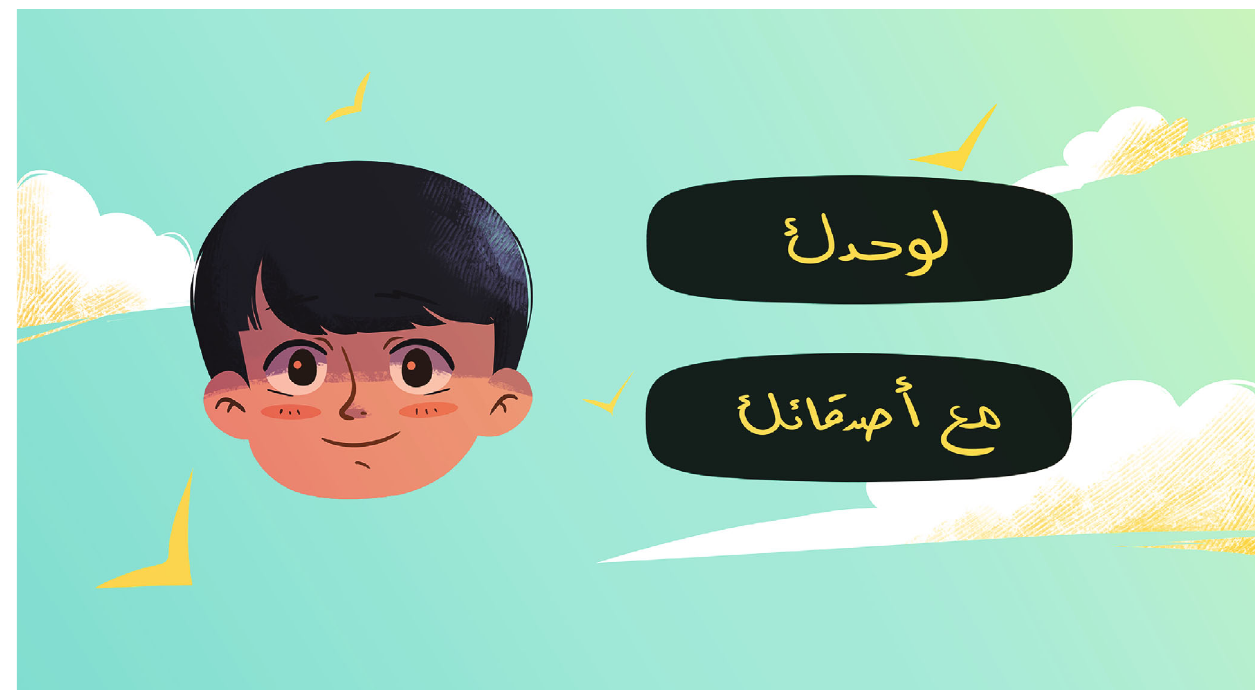
Figure 10: Sports ’ playing